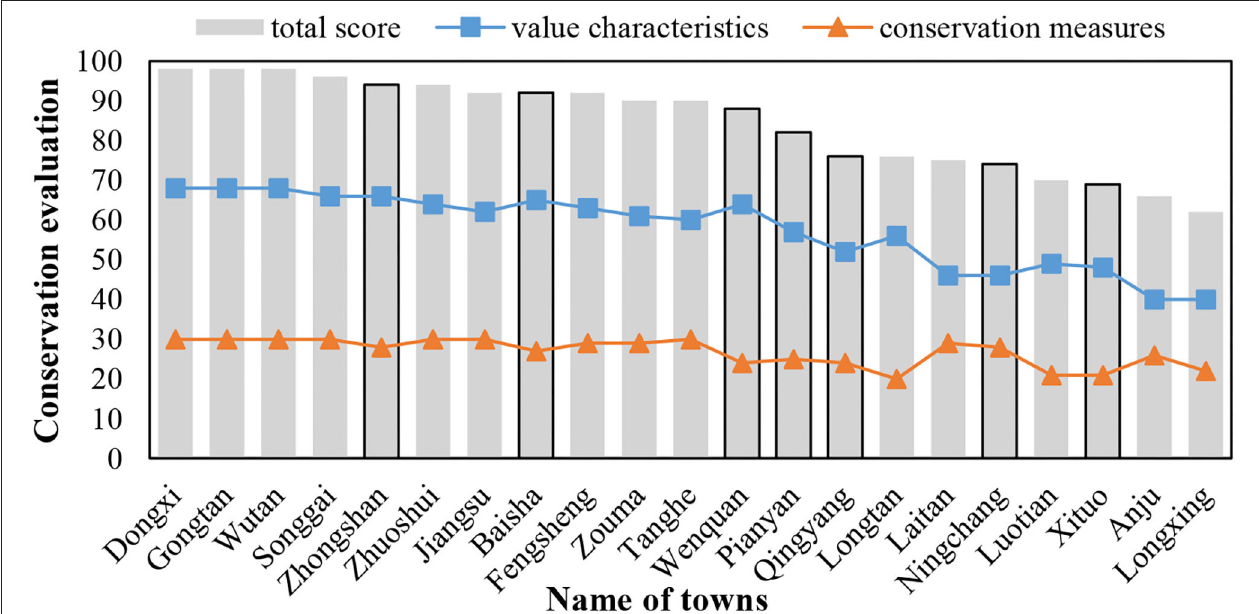
FIGURE 1 | Conservation evaluation of historical towns in Chongqing, China ( n =